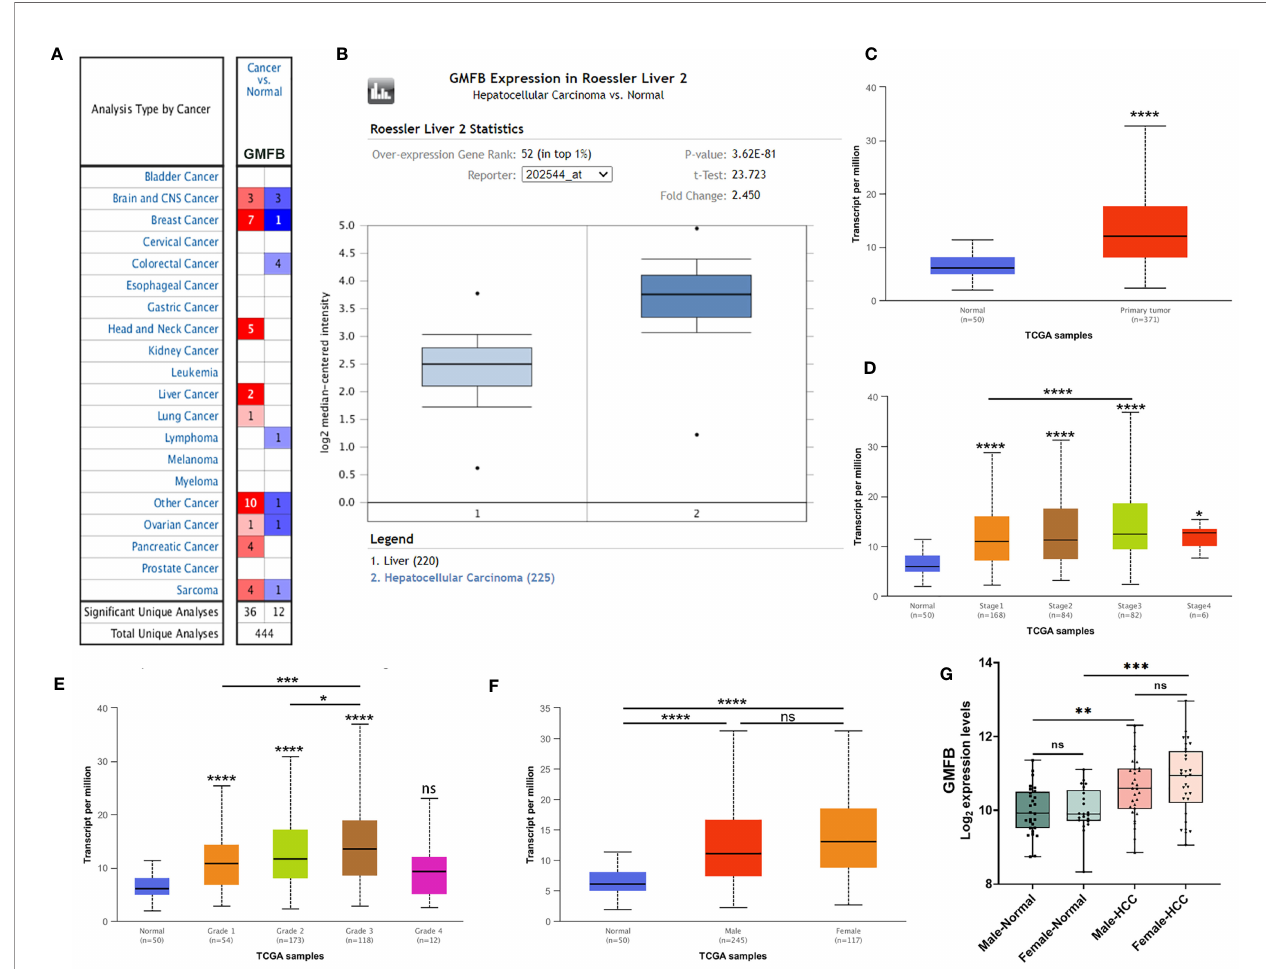
FIGURE 1 | GMFB expression levels in tumors based on sample types, tumor stage, tumor grade. (A) The transcription levels of GMFB in different types of cancers from the Oncomine database. The schematic in each cell reveals the numbers of datasets with statistically signi fi cant. The cell color is determined by the best gene rank percentile, red indicating high expression and blue indicating low expression. (B) The expression of GMFB in HCC and normal liver tissues from the Oncomine database. (C) The transcription levels of GMFB in HCC and normal tissues were analyzed by the UALCAN cancer database. The expression of GMFB in HCC is based on tumor stage (D) , tumor grade (E) , and gender (F) from the UALCAN database. (G) The transcription levels of GMFB in male normal, female normal, male HCC and female HCC tissues were analyzed by the NetworkAnalyst. *P < 0.05, **P < 0.01, ***P < 0.001, ****P < 0.0001, ns, no signi fi